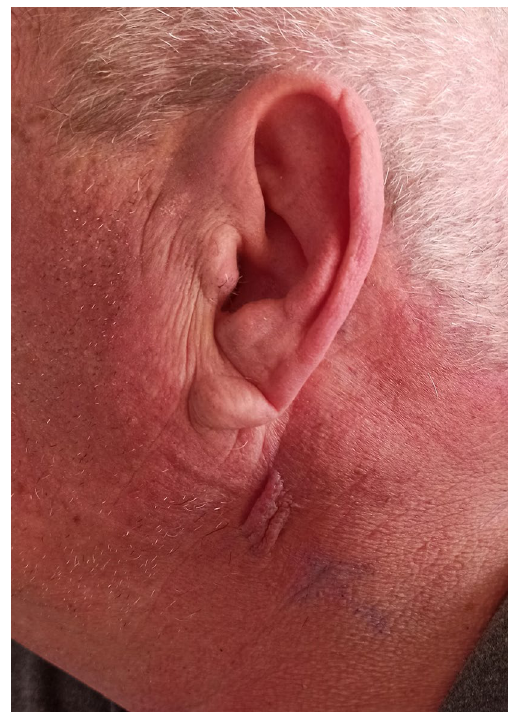
Fig. 6 . The mass appearance after 2 cycles of neoadjuvant treatment (after 8